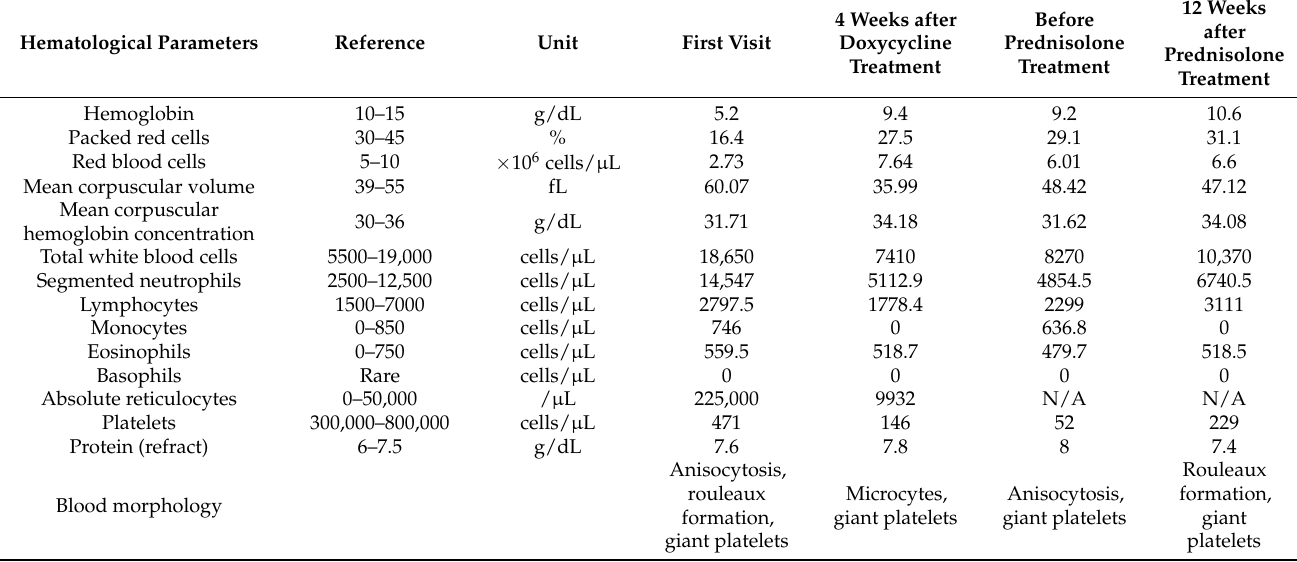
Table 1. Hematological profile at first visit, 4 weeks after doxycycline treatment, before prednisolone treatment, and 12 weeks after prednisolone